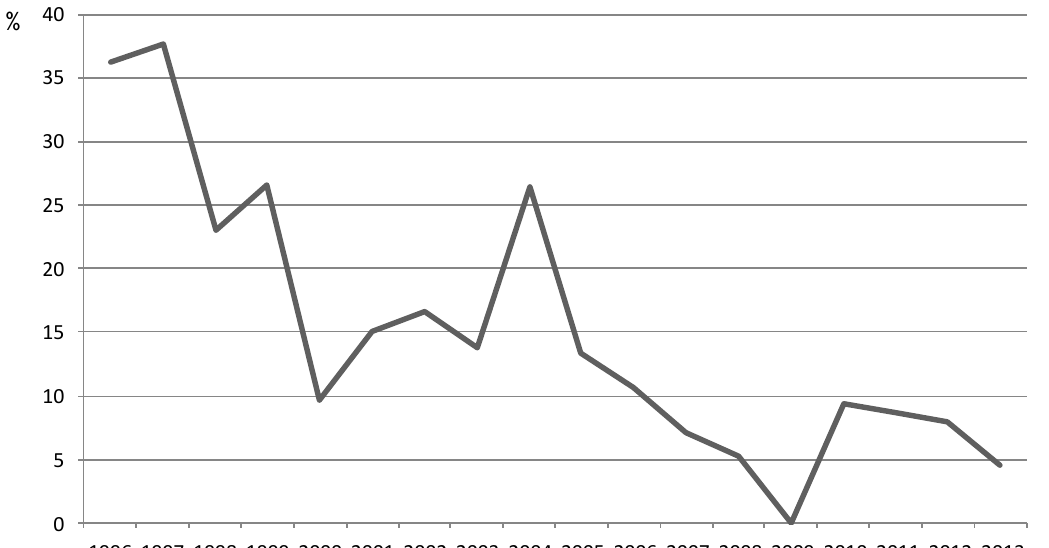
Figure 3. Distribution of seroprevalence by